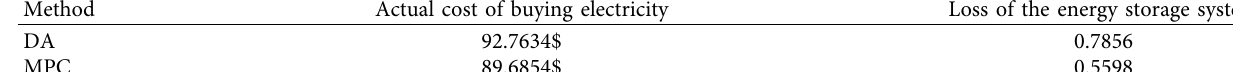
Table 4: Results of